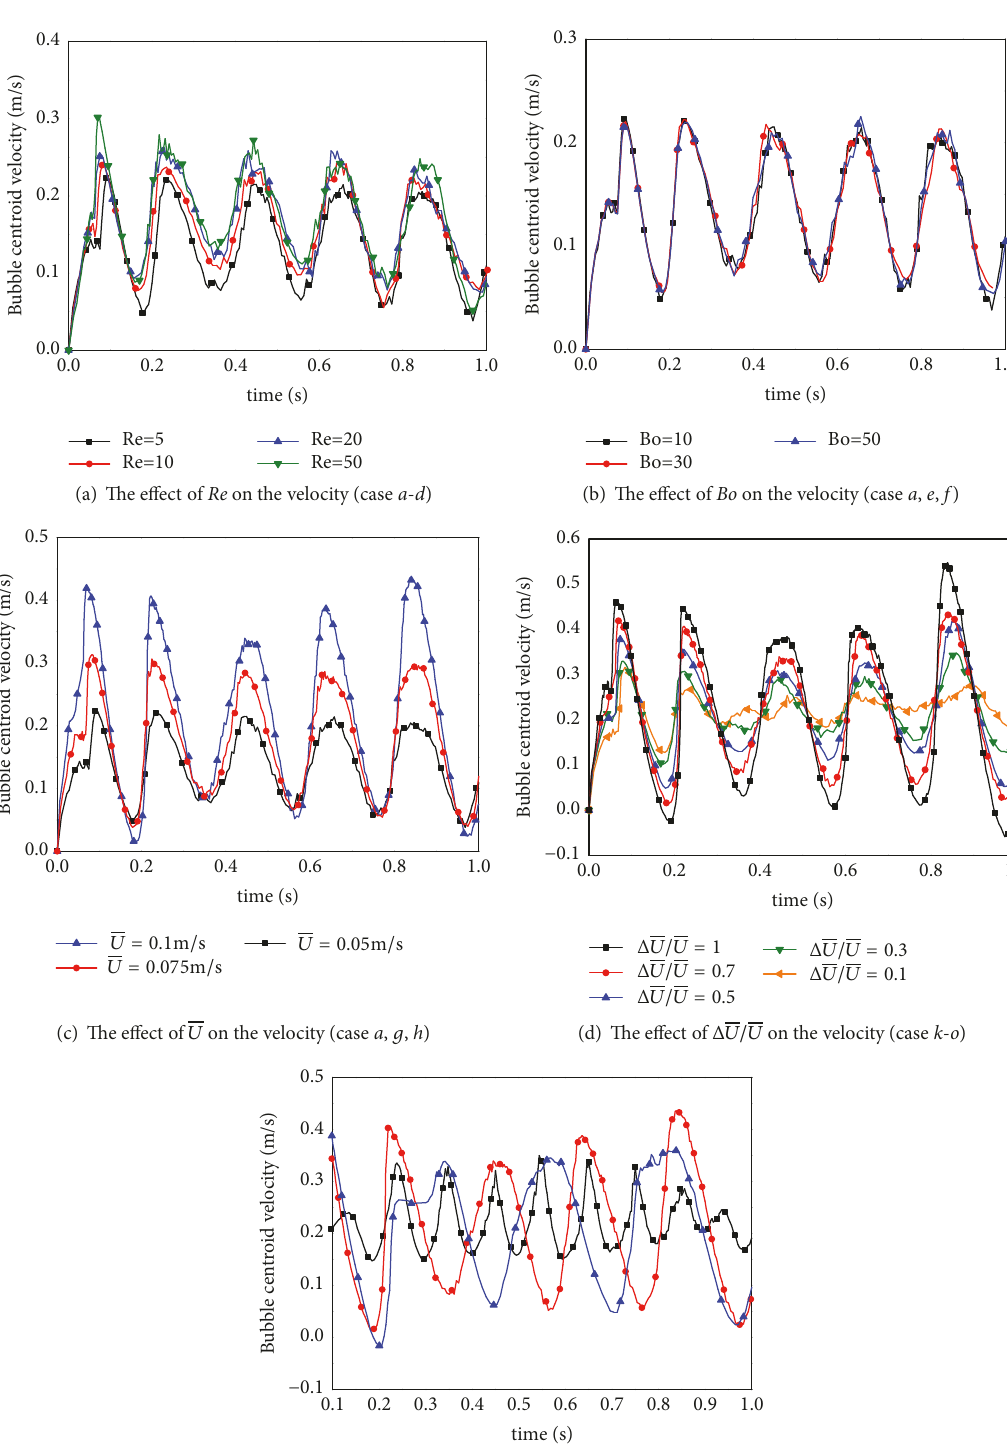
(e) The effect of 𝜏 on the velocity (case a , i , j ) Figure 10: The change of bubble centroid rising velocity with time under the influence of each independent